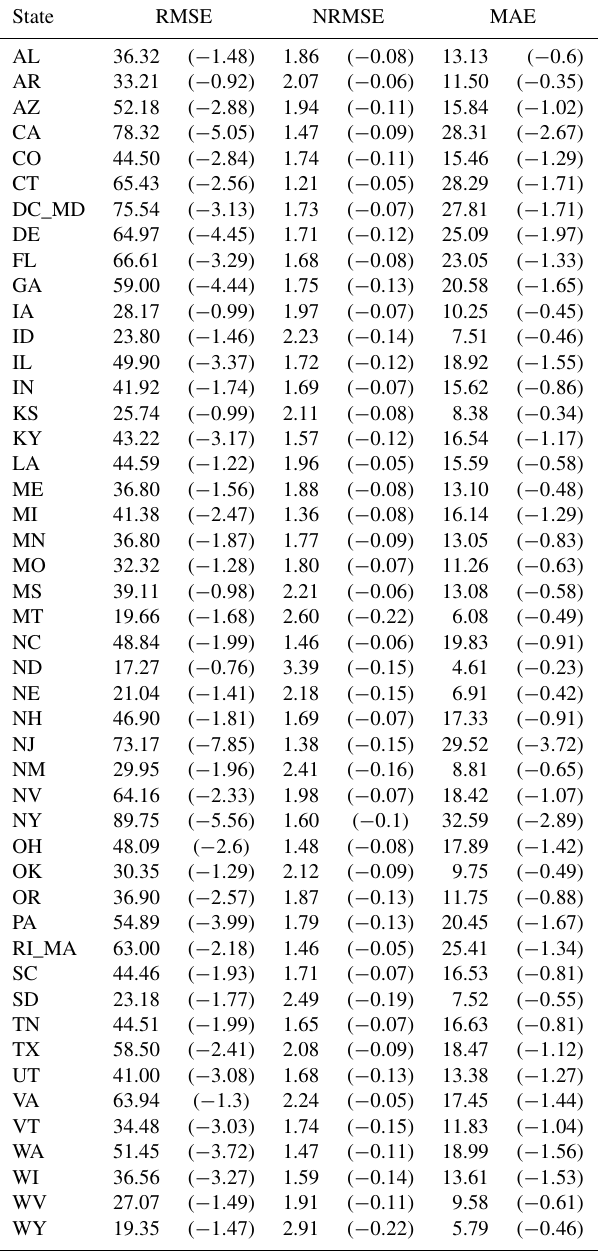
Table 3. Census block average error by state after applying block level representative population densities for each ancillary class to census tracts and ensuring pycnophylactic integrity at the tract level. Changes in error from the 2016 specification of uninhabited areas are in